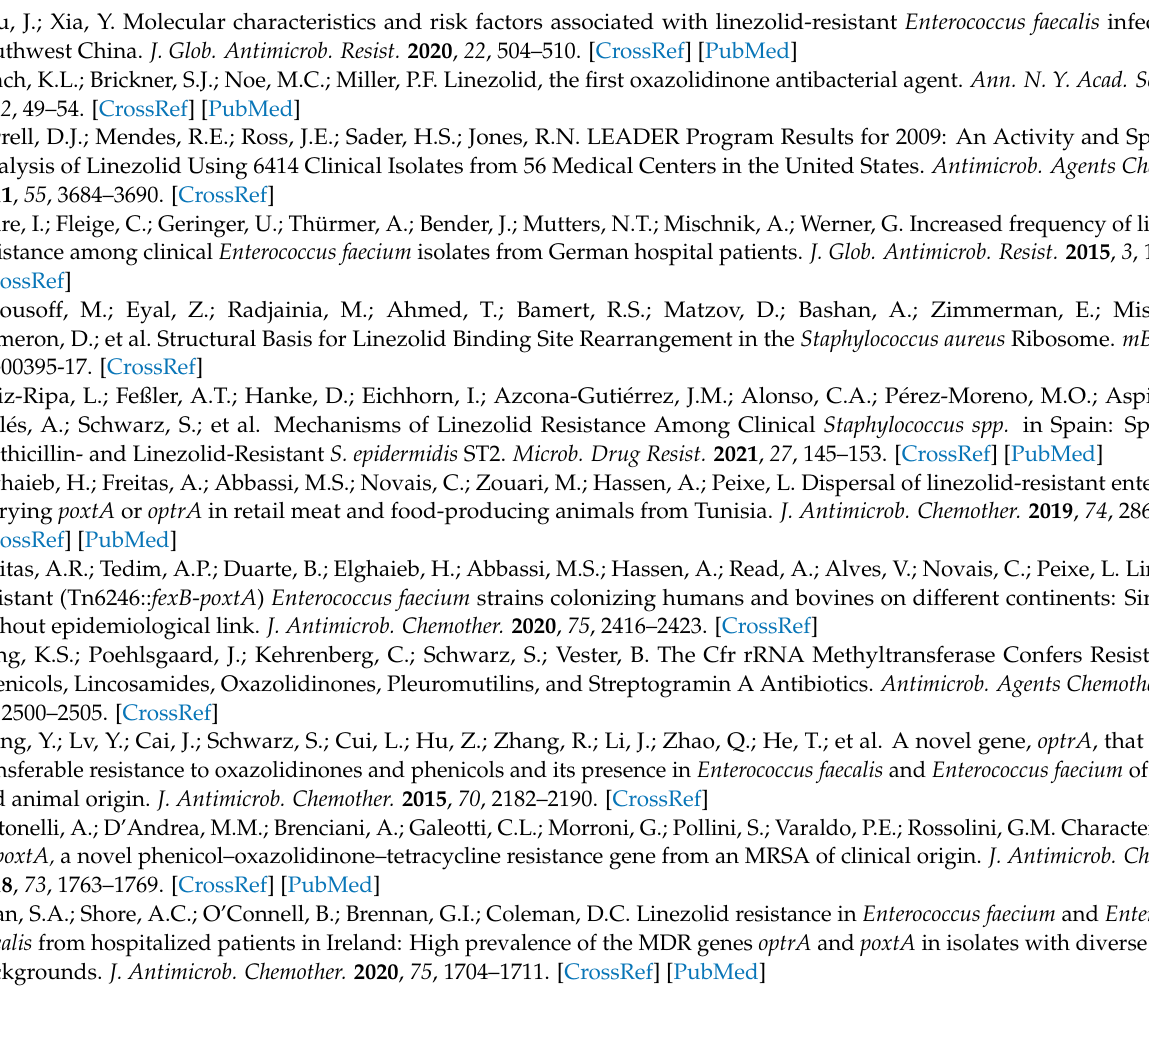
Figure S3: Determination of the artifactual inoculum effect observed with 10 µ L of a pure culture of a linezolid susceptible S. epidermidis isolate (A) 0.5 McFarland (~10 6 CFU), (B) dilutions in sterile water at 10 − 1 (~10 5 CFU) and 10 − 2 (~10 4 CFU), C. 10 − 3 (~10 3 CFU) and 10 − 4 (~10 2